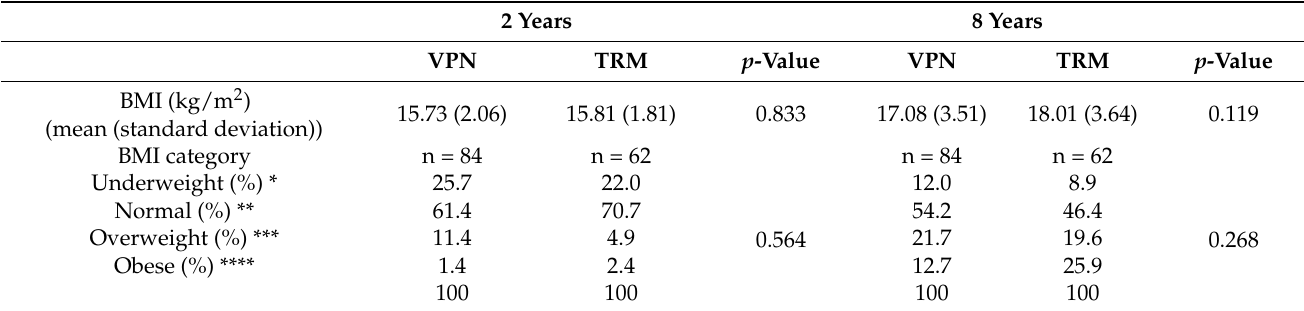
Table 2. BMI values and children’s classification based on BMI centile distribution at 2 and 8 years.